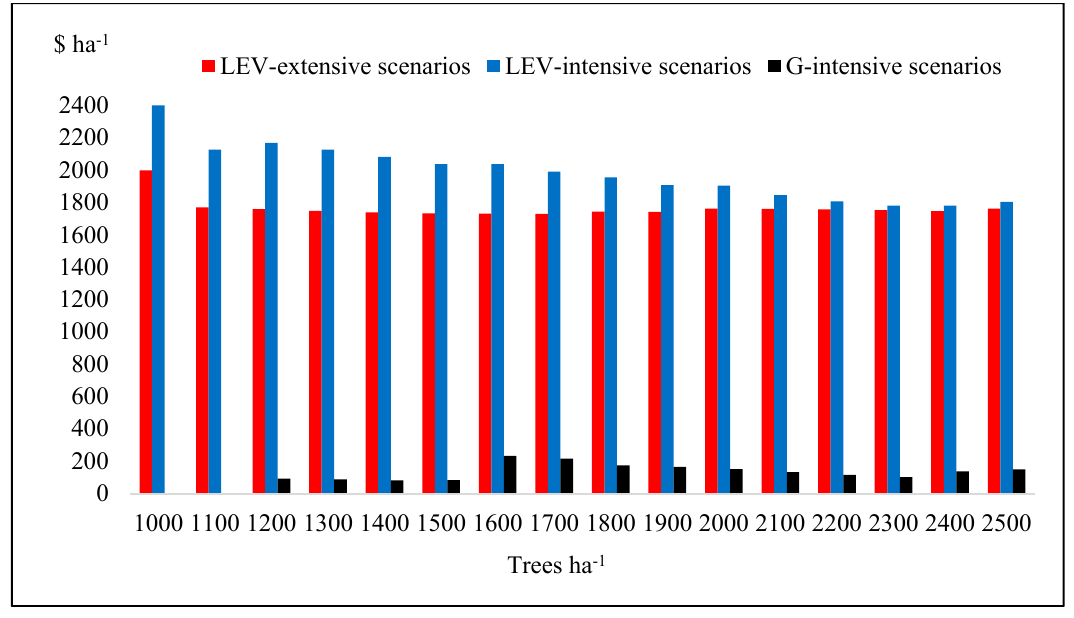
Figure 1. Land expectation value ( LEV ) and water yield benefits (G) for different slash pine planting densities and P w = $0.07 kL − 1